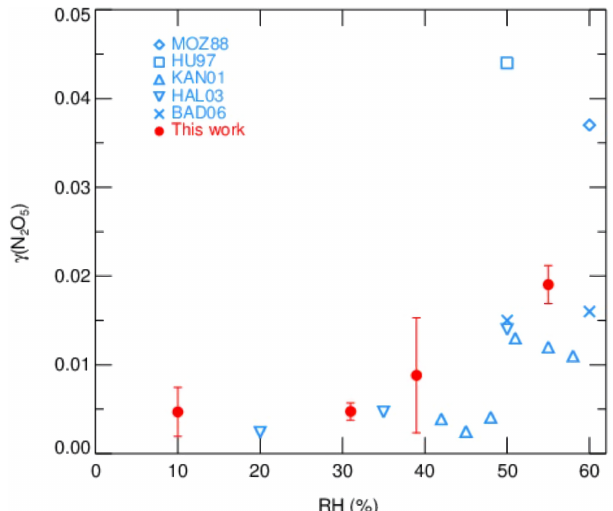
Figure 10. The dependence of γ( N 2 O 5 ) on RH for laboratory- generated ( NH 4 ) 2 SO 4 aerosols. The red points with standard de- viations represent the values measured by the current aerosol flow tube system in this work. Previously reported values are indicated in blue